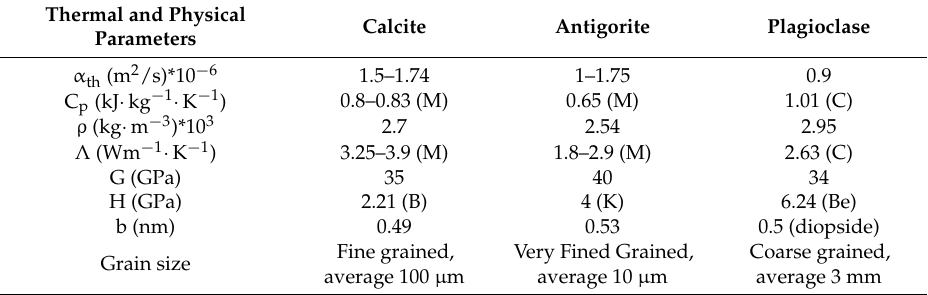
Table 1. Thermal and physical properties from Schön [47] with M: Melnikov et al. [48], C: Cermak and Rybach, [49]; B: Broz et al. [50]; Be = Beeler [9]. K: Koholi et al. [51].